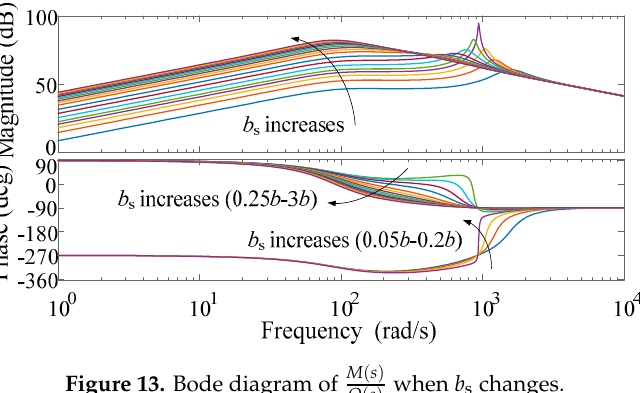
( s ) when b s changes. Q ( s )